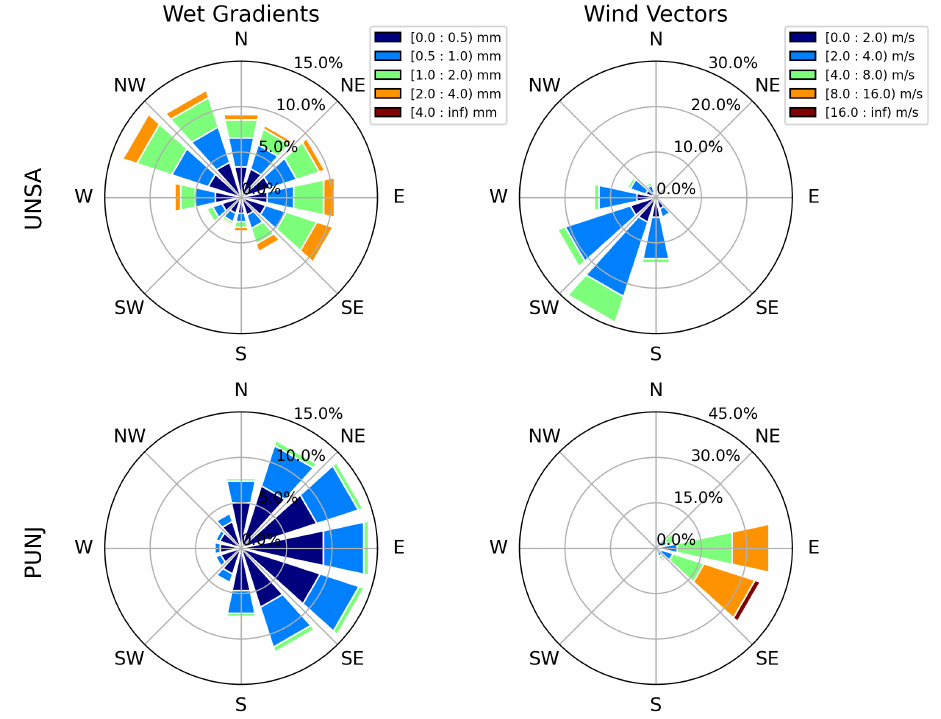
Figure 11. Azimuthal and magnitude distributions of the wet gradients and wind vectors of the UNSA and PUNJ stations. Wet gradients show the direction of moisture from the station location